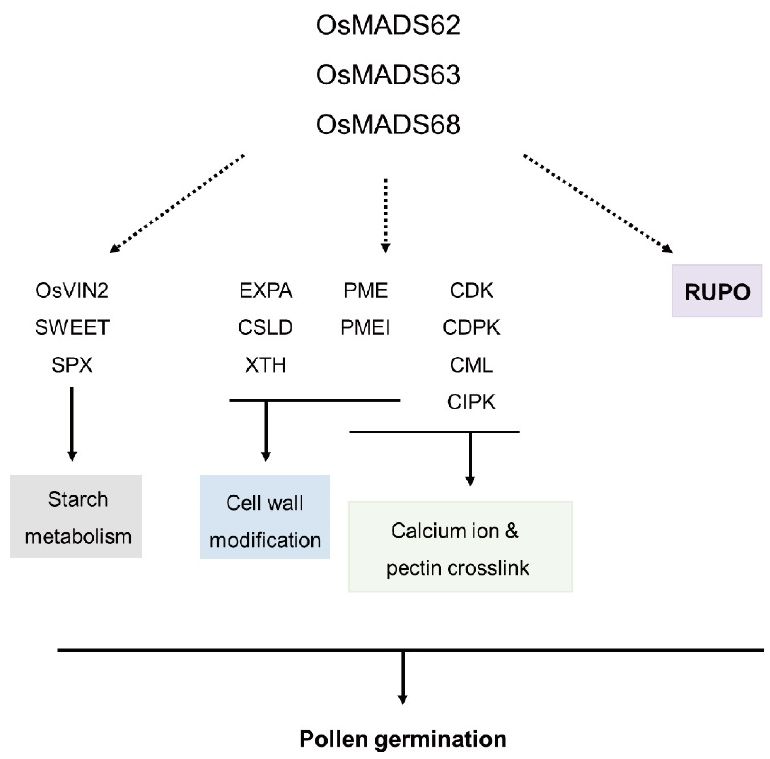
Figure 6. The model of downstream genes in three OsMADS .